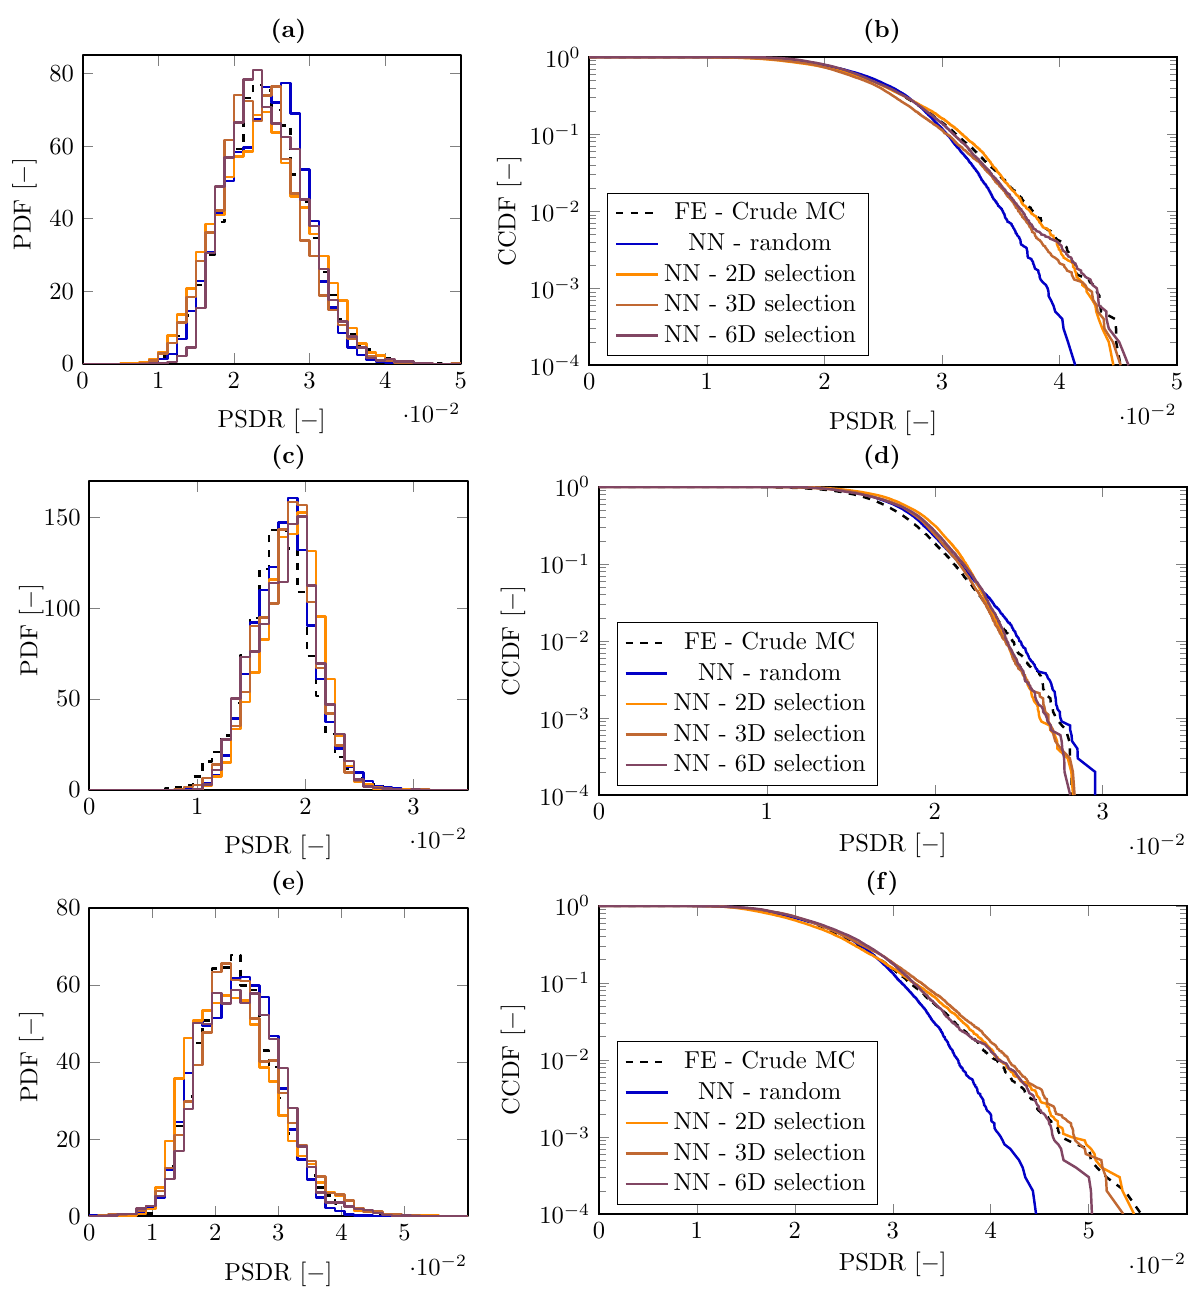
Figure 14. Response statistics. Structure A: ( a ) Probability density function and ( b ) complementary cumulative distribution function; Structure B: ( c ) Probability density function and ( d ) complementary cumulative distribution function; Structure C: ( e ) Probability density function and ( f ) complementary cumulative distribution function. Color scheme: Finite element solution (black, dashed), predicted solution from neural network with randomly chosen data (blue), predicted solution from neural network with selected data using selection process based on S d ( T 1 ) and S d ( T 1 ) (brown), predicted solution from neural network with selected data using selection process based on all six intensities (dark